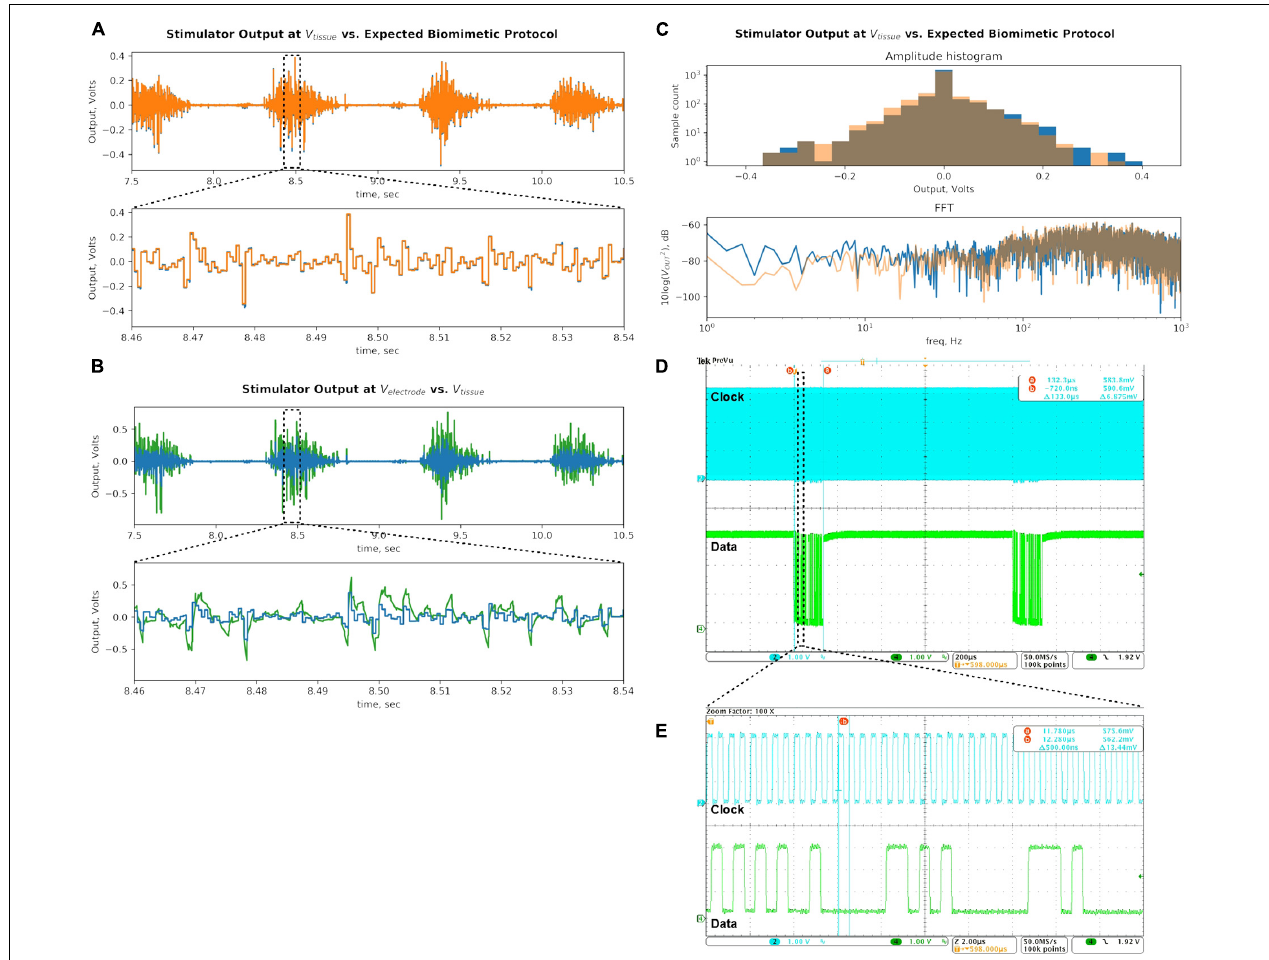
FIGURE 12 | Bench-top demonstration of multi-channel continuous DS waveform mimics a recorded EMG signal, which has been shown to be effective in epidural spinal cord stimulation for restoring motor function. (A) Stimulator output recorded at V tissue (blue) is compared to the desired biomimetic protocol waveform (orange). The signals are similar as intended, demonstrating the prototype’s ability to deliver gapless and continuous stimulation protocols. (B) Output recorded at V electrode (green) is compared to the signal at V tissue (blue). The electrode signal is higher in amplitude due to the added voltage drop across the C DL capacitor, which integrates the output current pulses, but is within the compliance limits of the SoC output current sources with significant margin. (C) The DS output of the stimulator (blue) is analyzed against the desired biomimetic protocol (orange).The biomimetic current protocol is multiplied by the R S value to convert it to voltage units. Histograms of amplitudes of signal peaks and frequency spectrums of the signals are plotted. (D) Clock and data digital inputs to the SoC are plotted. Spacing between data packets identifies the sampling rate of the output stimulus signal. Total time period of a packet helps calculate the number of bits it contains, by using the clock period (E) . Combination of information in panels (D,E) yields the total data bitrate of the DS biomimetic stimulation